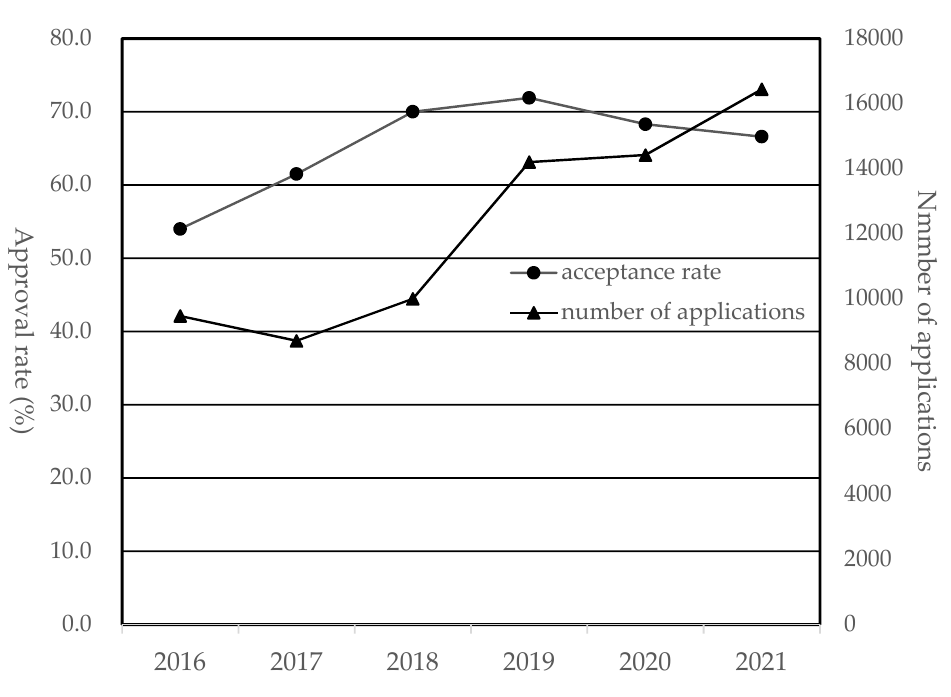
Figure 7. Number of applications and WMSD approval rates by year.